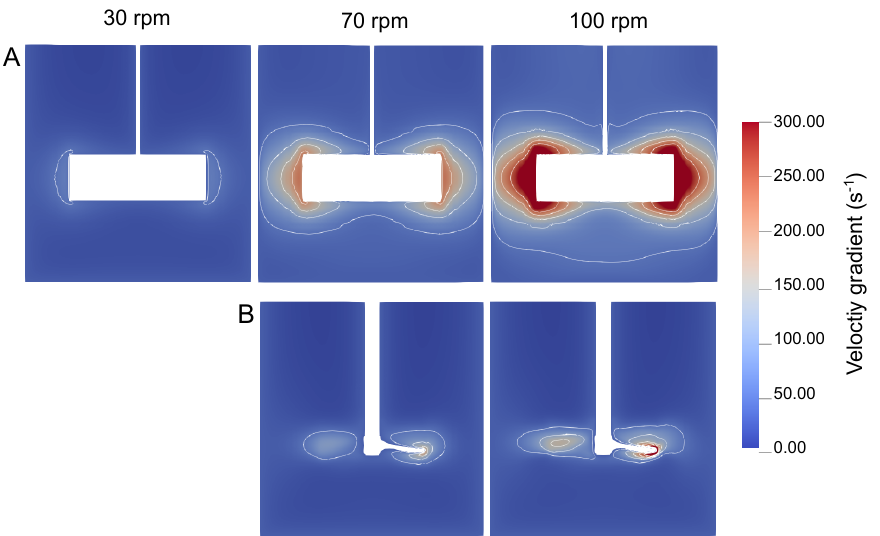
Figure 7. Contours of local velocity gradients in a vertical plane ( x = 0) of the jar, equipped with the radial ( A ) and the axial ( B ) mixers, for different impeller